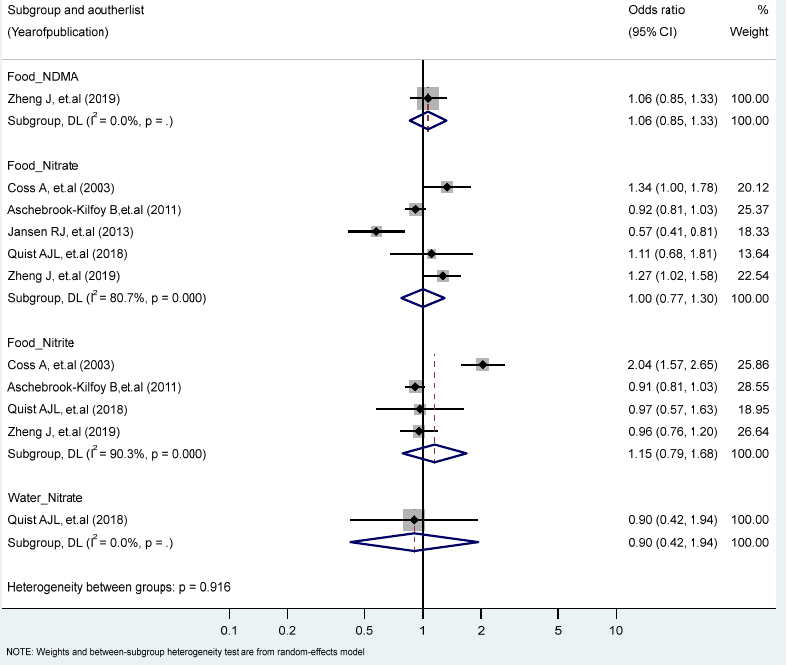
Figure 5. Forest plot (random-effects model) quantifying the relationships between NDMA, nitrite, and nitrate intake and pancreatic cancer risk stratified by sources. List of references includes: [37,48,52,58,61].